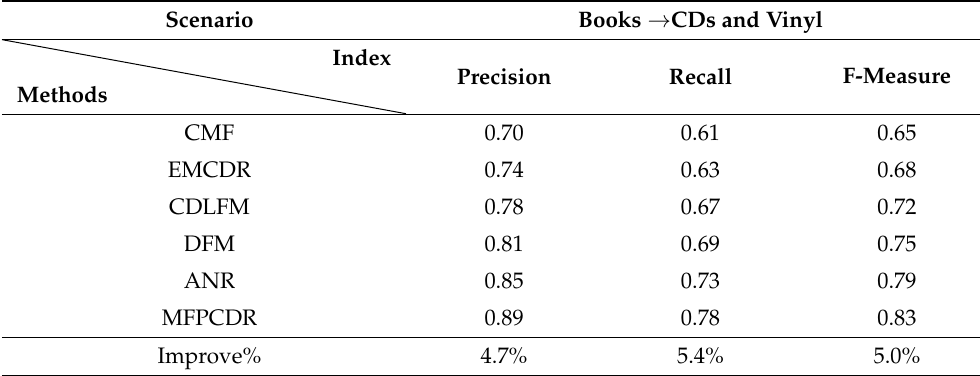
Table 3. Precision, Recall, and F-measure experimental results